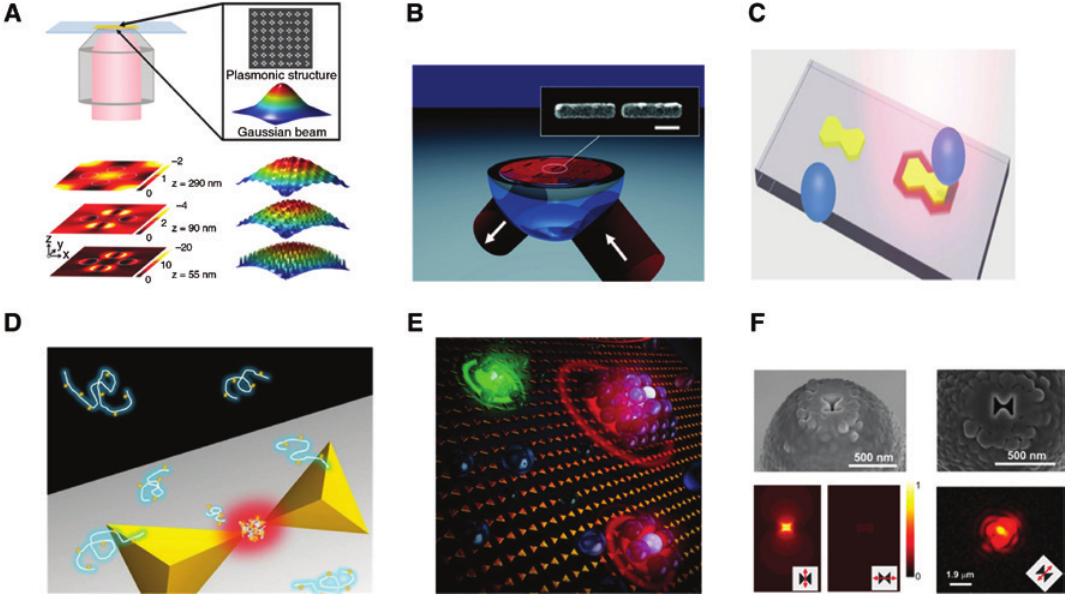
Figure 2: Plasmonic optical tweezers